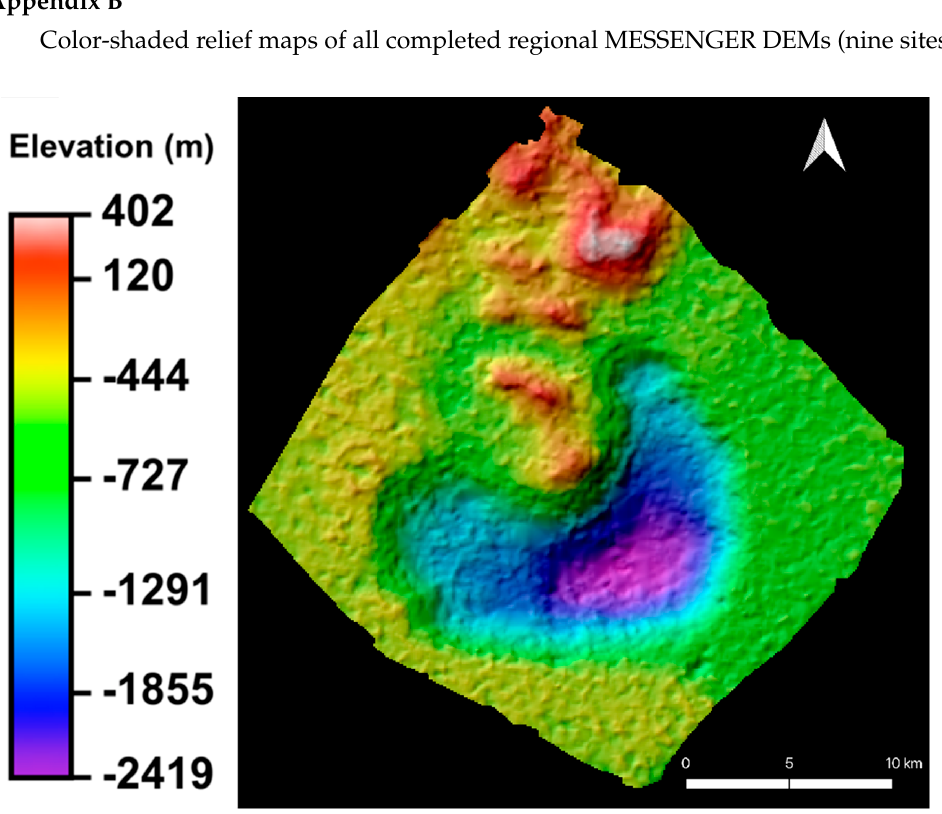
Figure A2. Cunningham Crater.